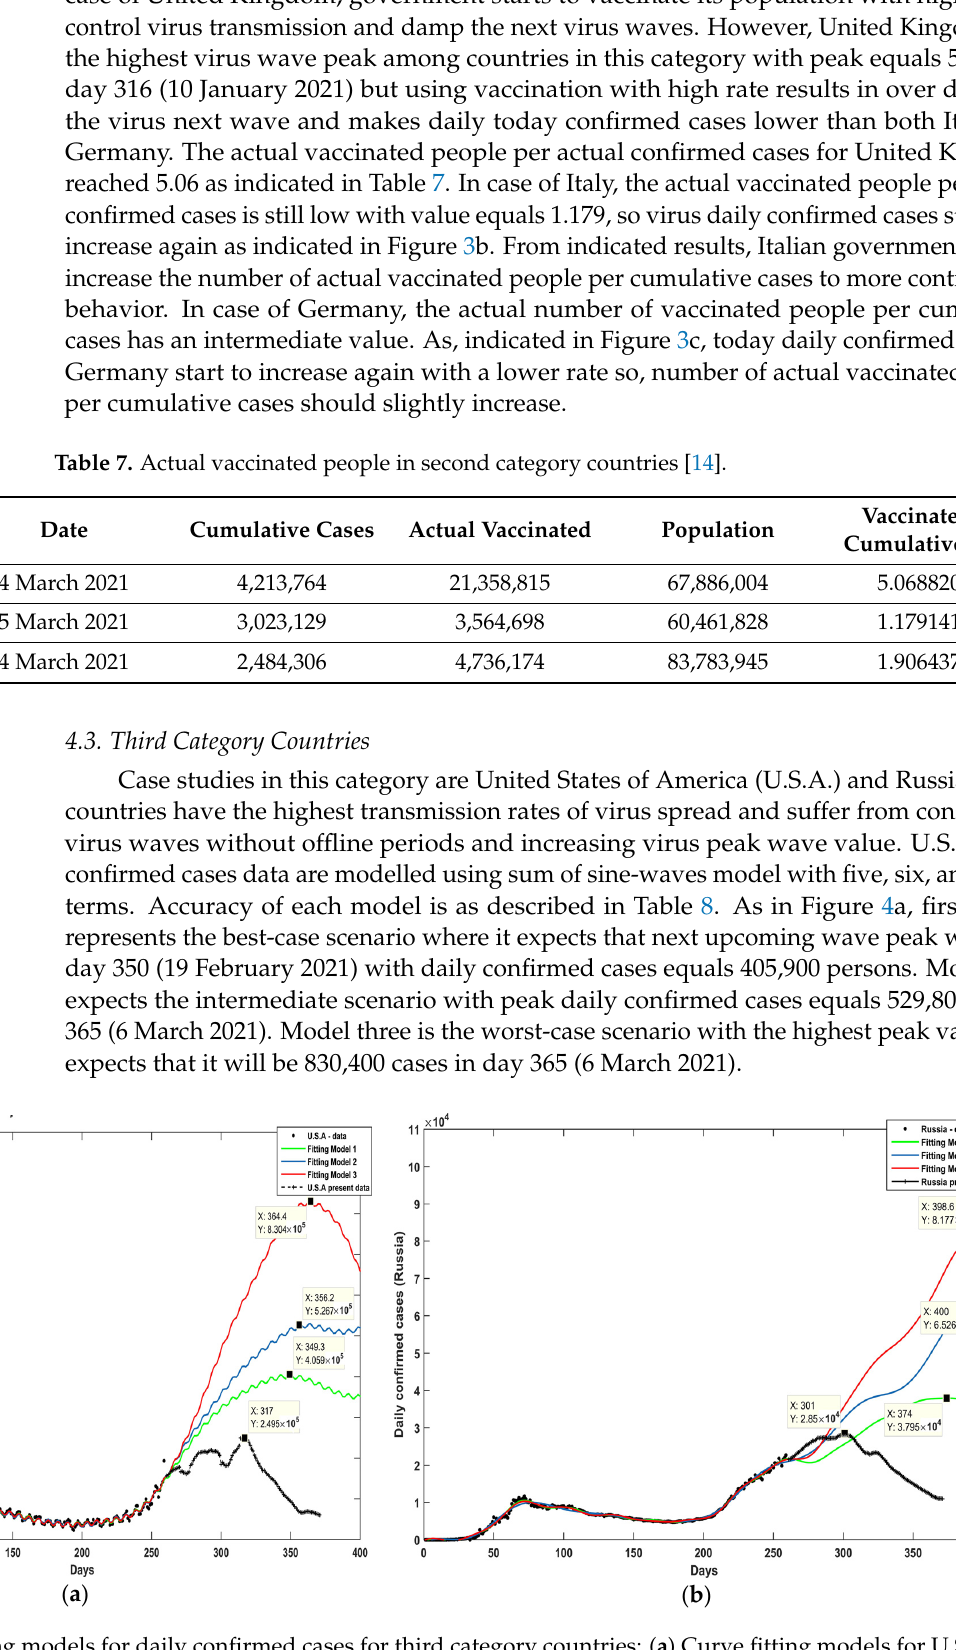
Figure 4. Curve fitting models for daily confirmed cases for third category countries: ( a ) Curve fitting models for U.S.A. data; ( b ) Curve fitting models for Russia data.